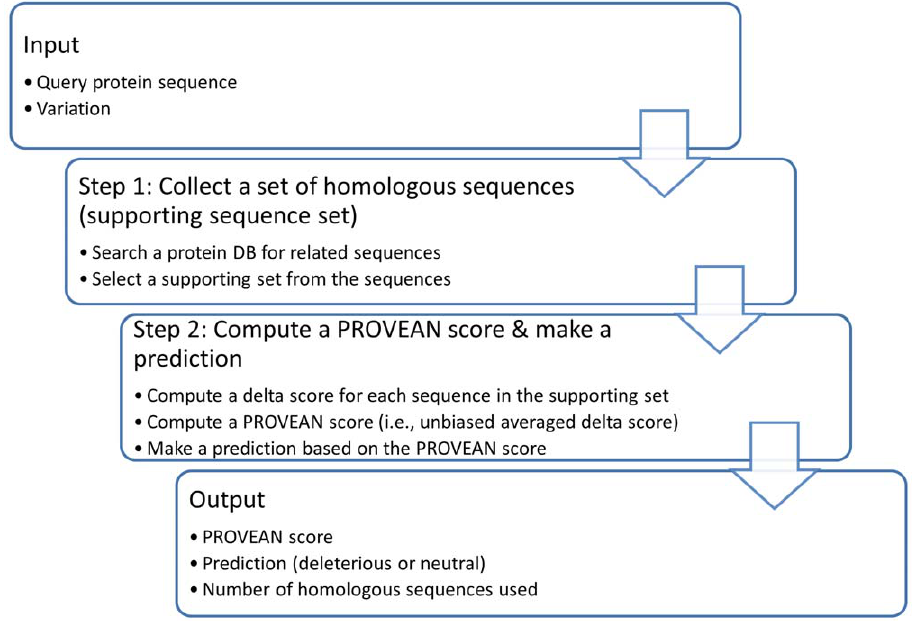
Figure 2. An overview of the PROVEAN procedure.